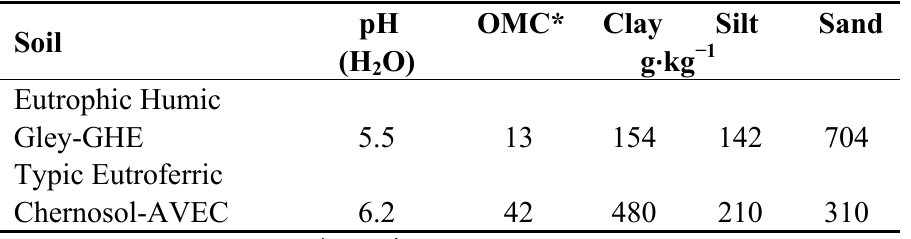
Table 1. Main physical and chemical characteristics of